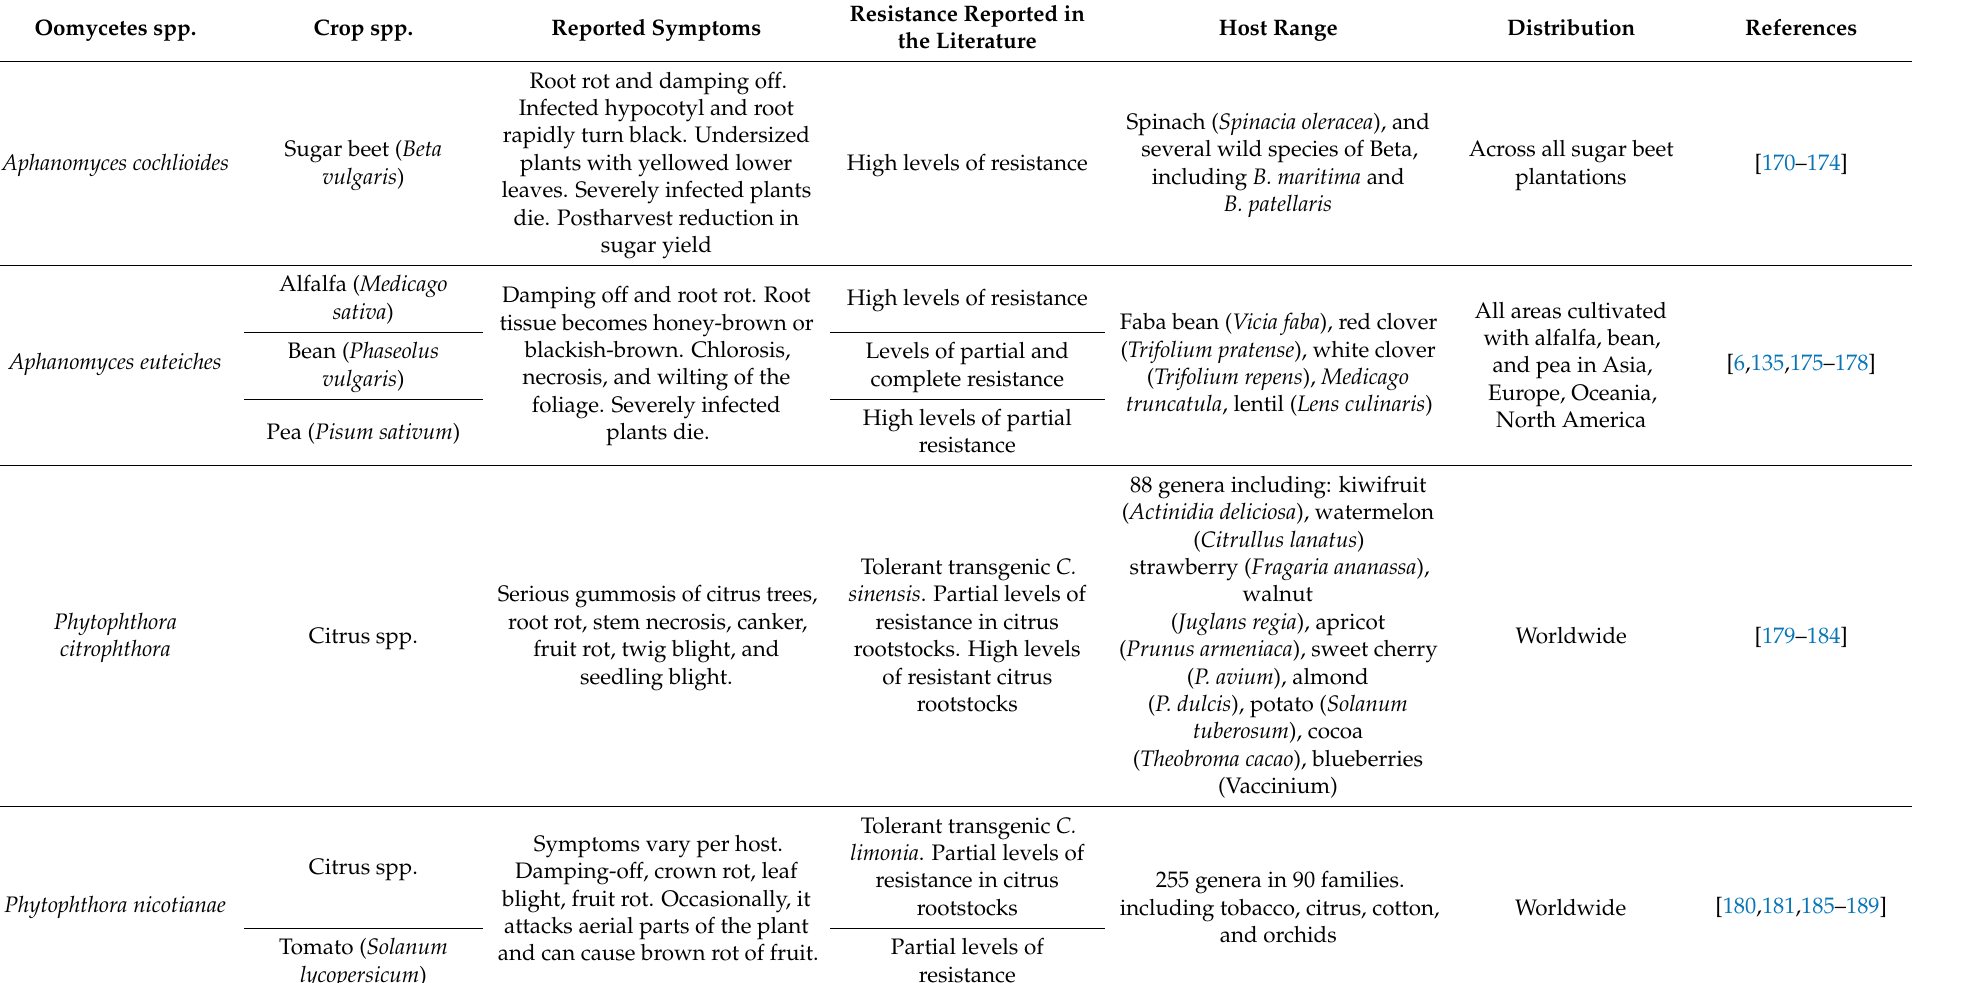
Table 4. Main oomycete species that cause root rot disease in crop